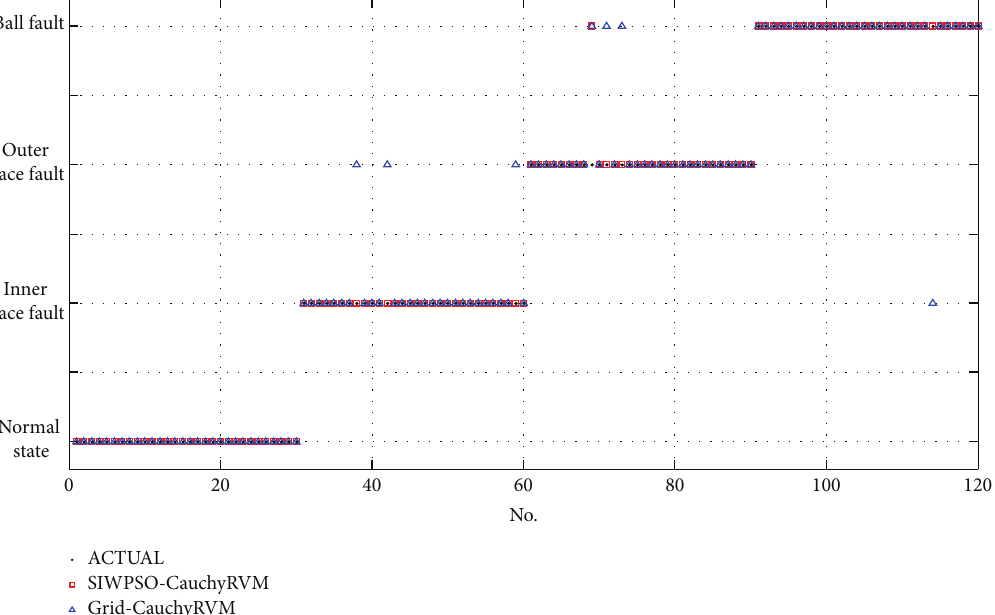
In stochastic inertia weight PSO, stochastic inertia